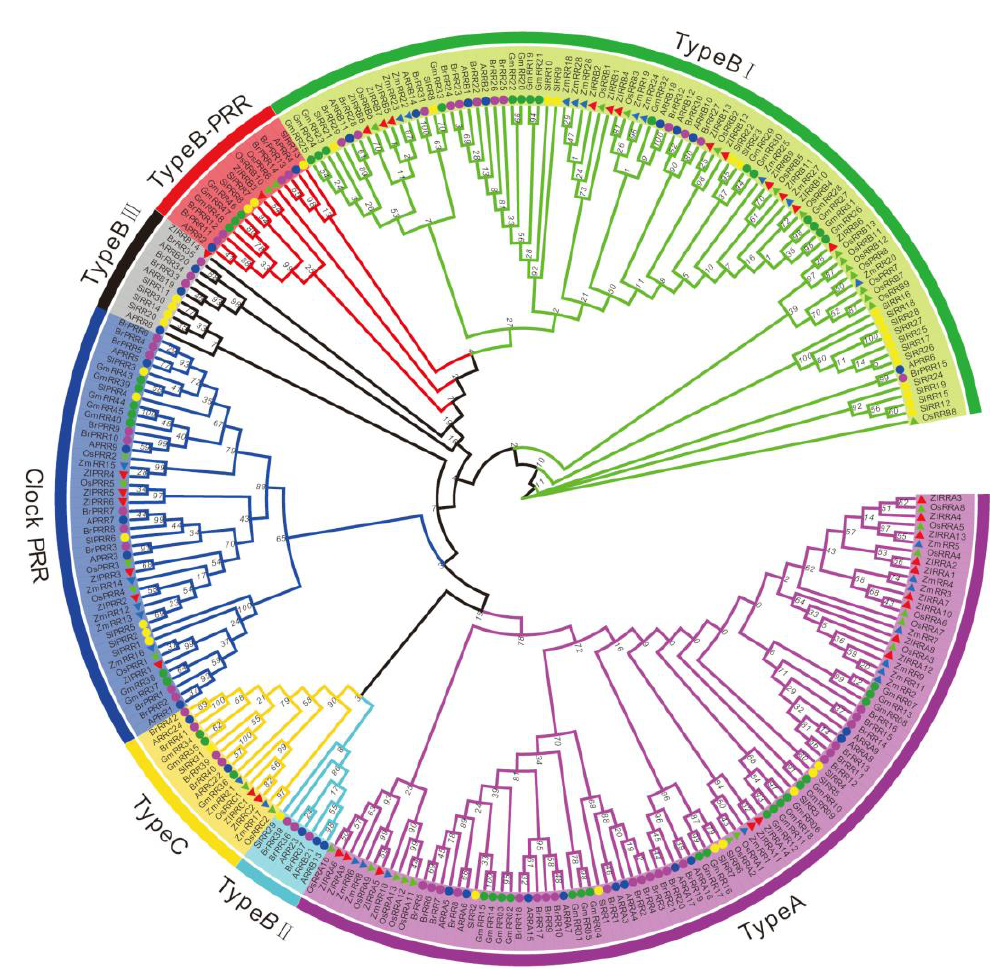
Figure 4. Phylogenetic relationship of response regulator (RR) proteins and related proteins in Arabidopsis , rice, maize, soybean, Chinese cabbage, tomato, and Z. latifolia .